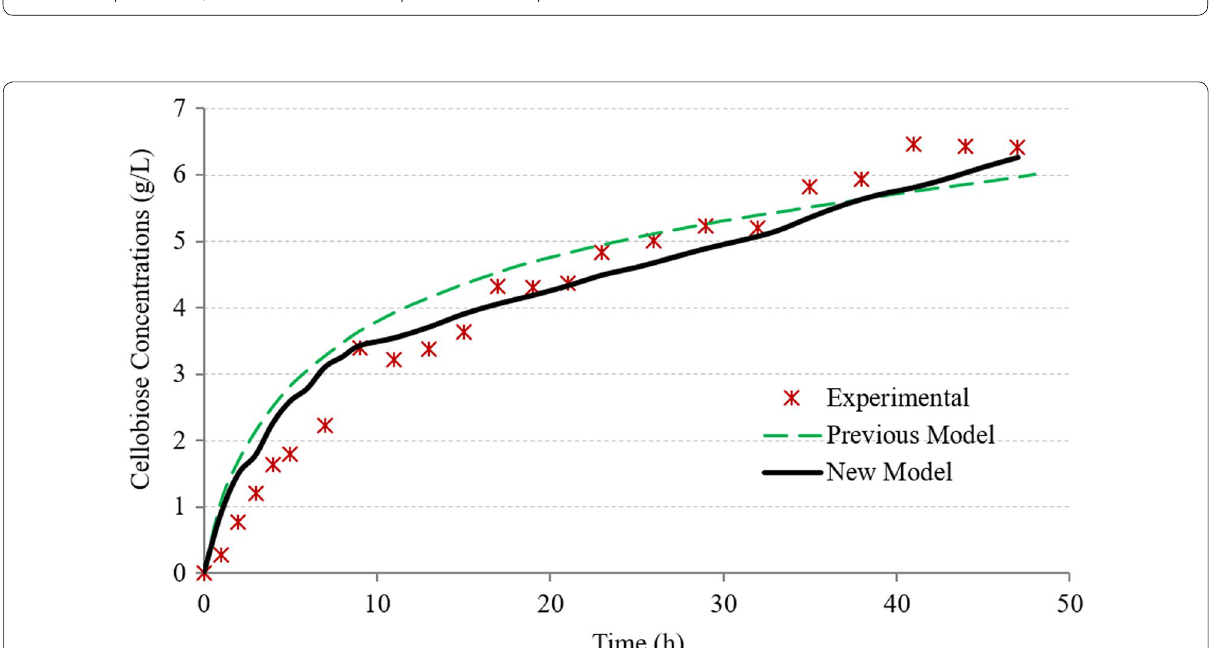
Fig. 7 Comparison of model simulations (current and previous version) and experimental data of cellobiose production during hydrolysis of Avicel (25 g/L) at 40 mg/g cellulose loading The data points are from literature studies (Bezerra and Dias 2004; Bezerra et al. 2011), solid lines are from the new model predictions, and dotted lines are for predictions from previous version of